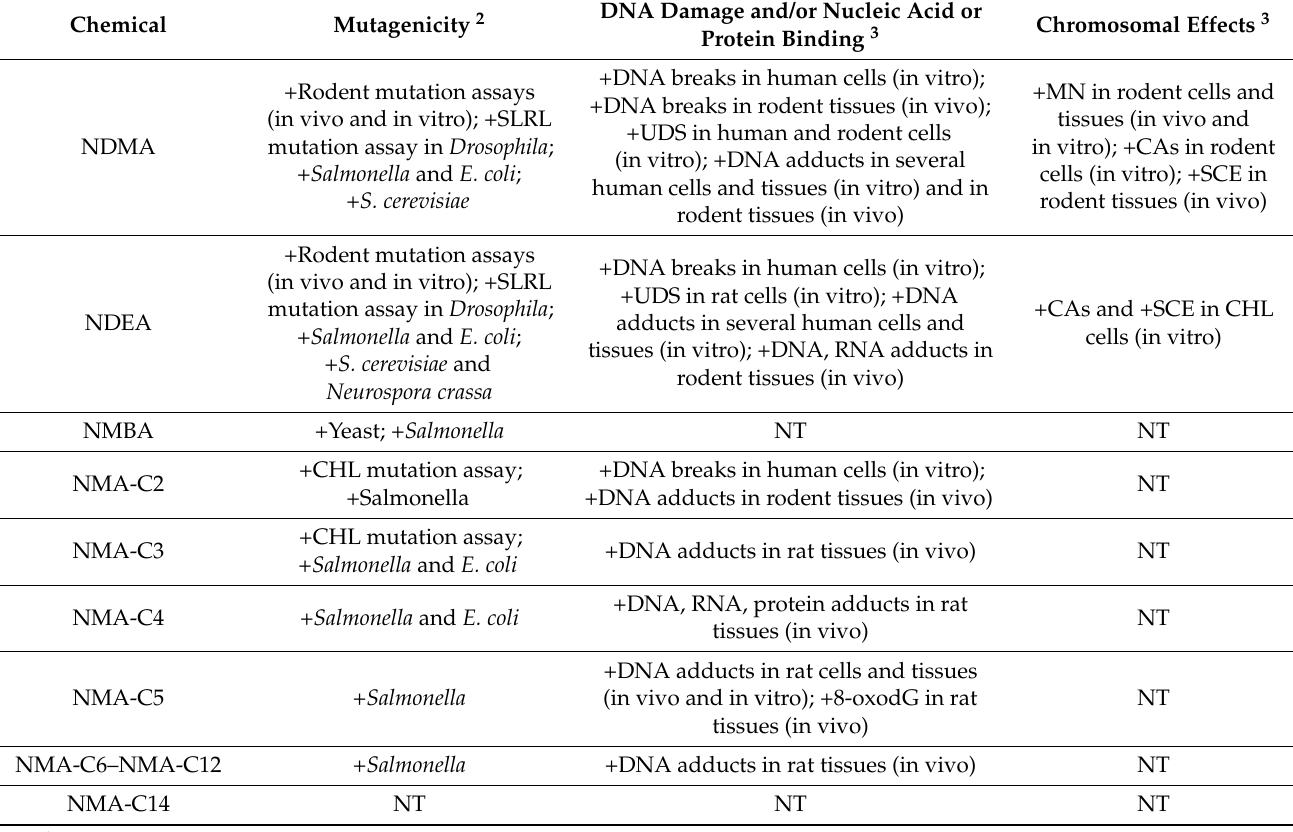
Table 3. Summary 1 of genotoxicity findings for NMAs (including NDMA), NDEA, and NMBA.